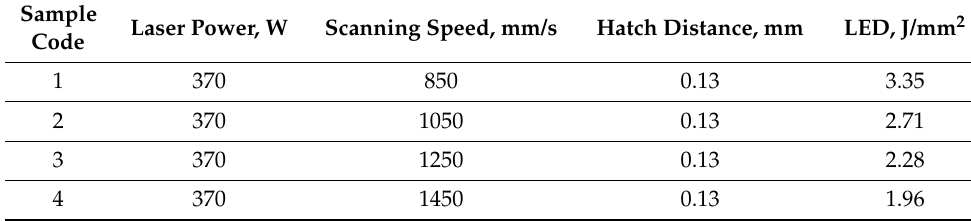
Table 1. Printing modes of AlSi10MgCu–diamond